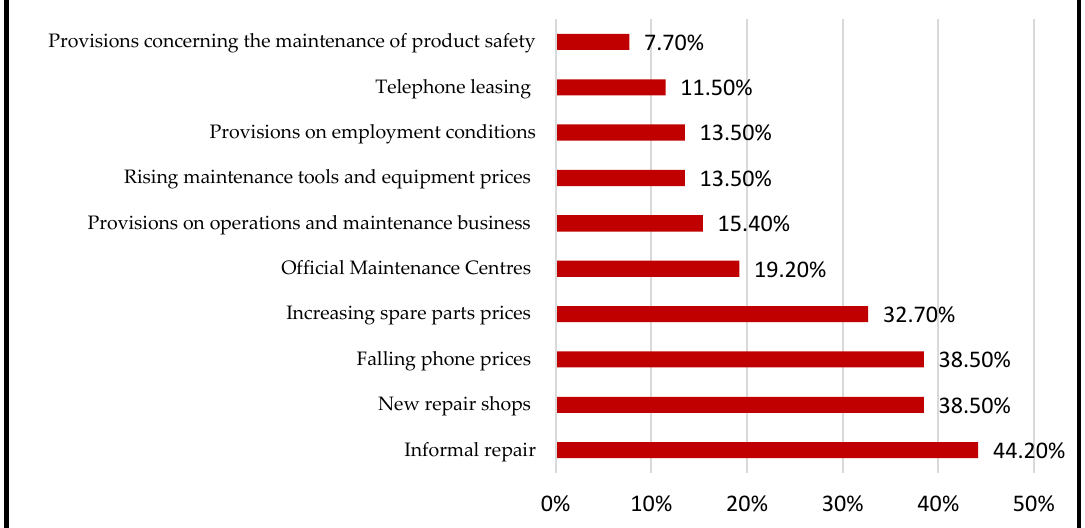
Figure 7. Business threats to mobile phone repair shops in Poland .